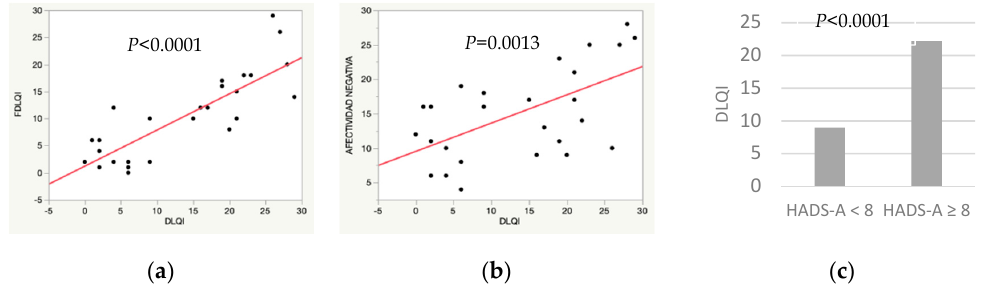
Figure 2. Potential factors associated with worse quality of life in patients with hidradenitis suppurativa. ( a ) Simple linear regression. Familiar Dermatology Life Quality Index (FDLQI) / Dermatology